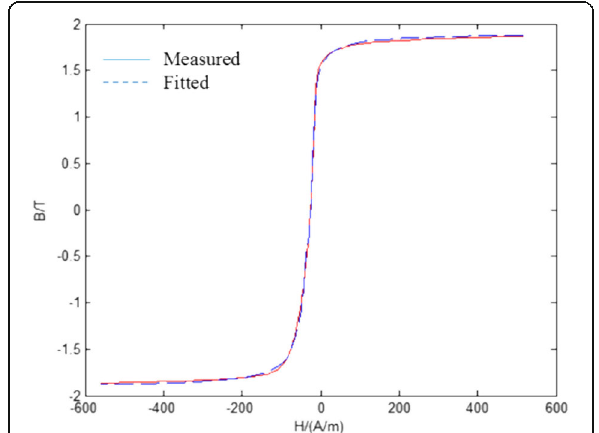
Fig. 4 Descending branch of limiting hysteresis loop of closed-core and its fitted curve